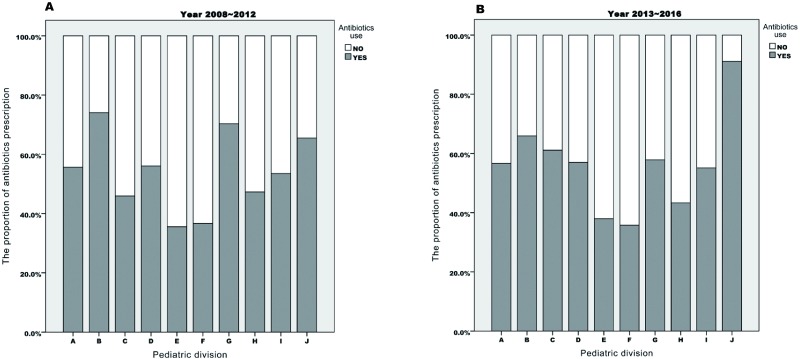
Comparison of antibiotics prescribing behavior between 10 divisions of Pediatrics.